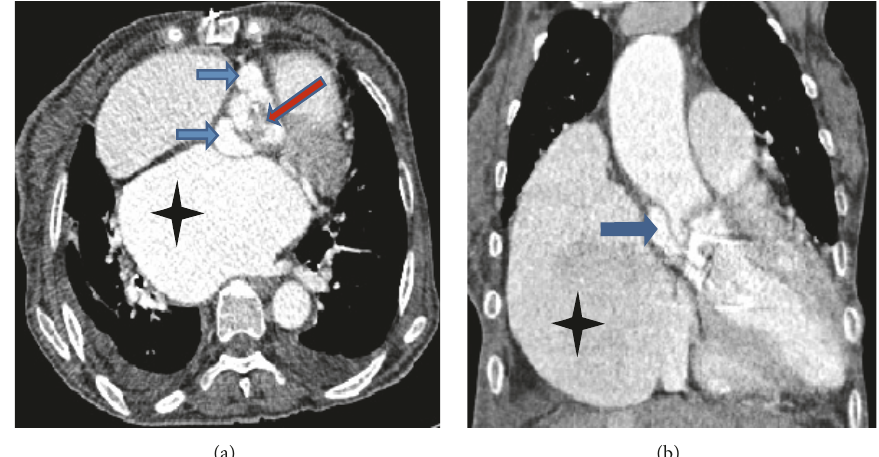
Figure 3: CT displays (a) on axial plane an irregular, deformed aortic valve, in which there is hypodense material (red arrow), two pseudoaneurysms (blue arrows), and dilated left atrium (black star). (b) Coronal reconstruction showing a pseudoaneurysm at the base of the ascending aorta (blue arrow) and dilated left atrium (black